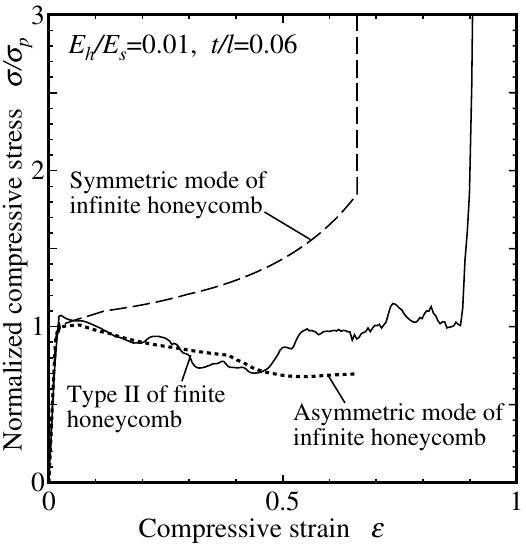
Figure 19. Stress-strain responses for finite and infinite honeycombs (Type II; t/l = 0.06).